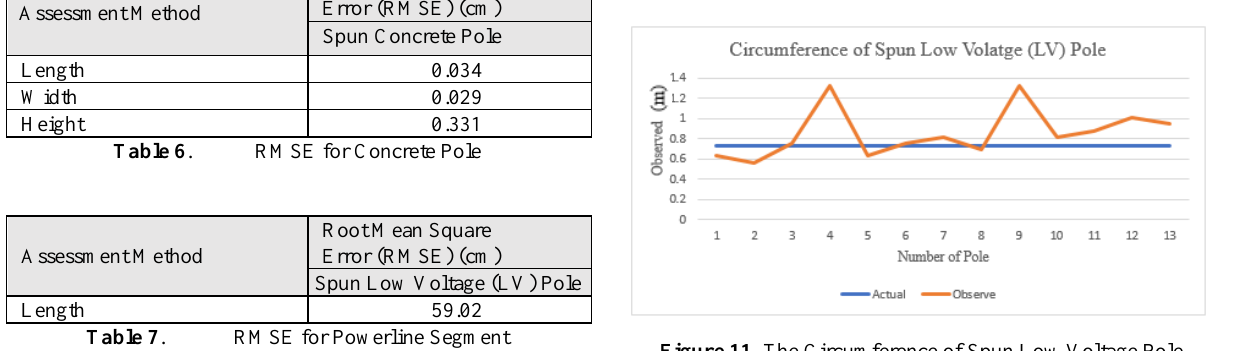
Figure 10 . The Diameter of Spun Low Voltage Pole Figure 10 shows the diameter of spun pole low voltage. Based on the graph, the value of diameter that observed in pole number 4 RMSE for Spun Pole Low Voltage and pole number 9 are higher than the actual value which is 0.42m for both pole number 4 and pole number 9. The actual value for diameter is 0.24m.